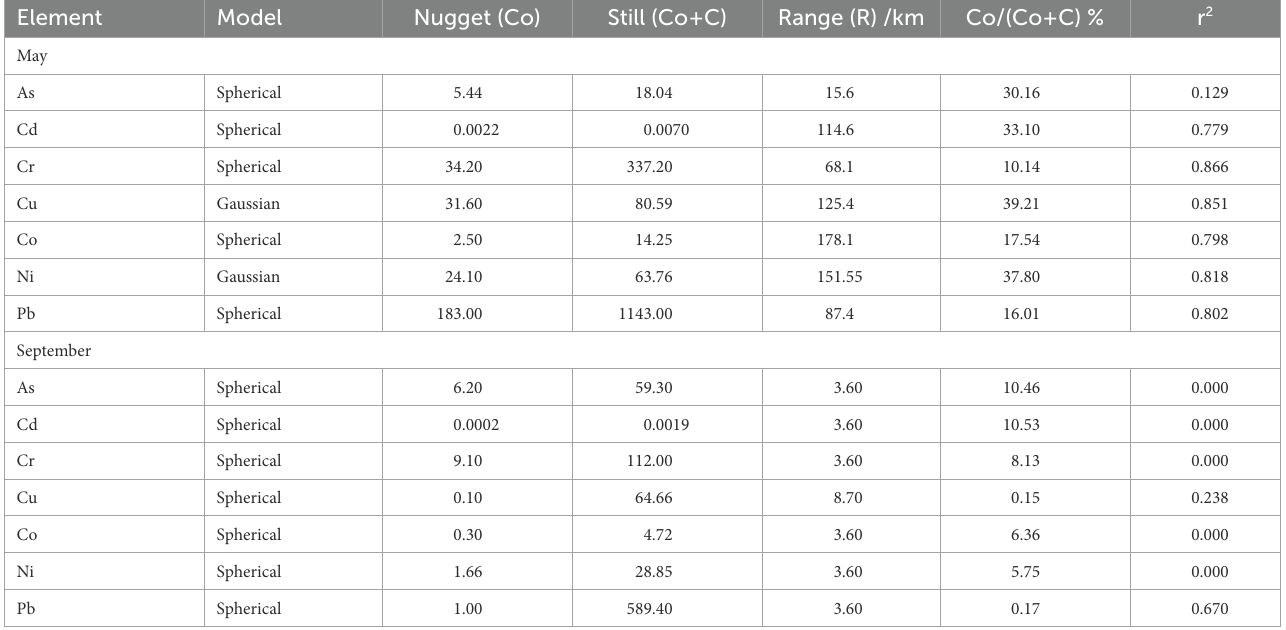
TABLE 5 Results of semi-variance analyses of heavy metal concentrations in topsoil. Element